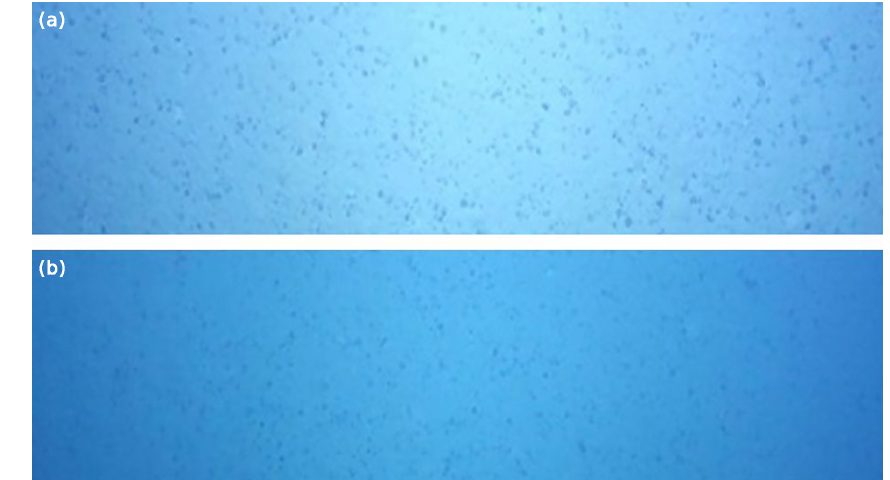
Figure 8. Adjacent AUV photos from consecutive dive tracks that were obtained inside subarea b from (a) lower (5–7m) and (b) higher (9–11m) altitudes. Note the decrement in the image brightness. (The area of the photos represents the central part of the photo, i.e., ca. 1 / 4 of the original photo size.)